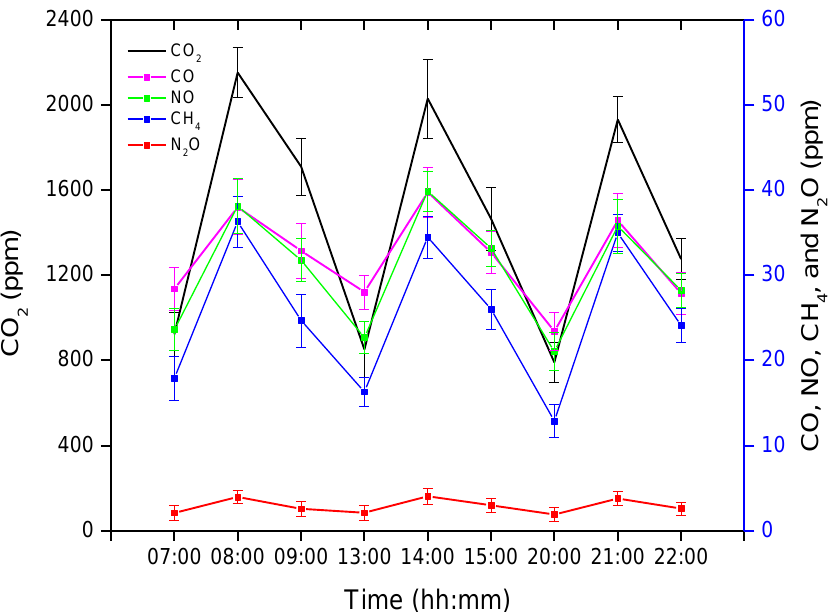
Figure 6. Average greenhouse gas (GHG) concentrations before, during, and after an hour of treatment. The x-axis represents the time (hh:mm) of day, whereas the left y-axis represents the average CO 2 concentration, and the right y-axis represents the average CO, NO, CH 4 , and N 2 O.